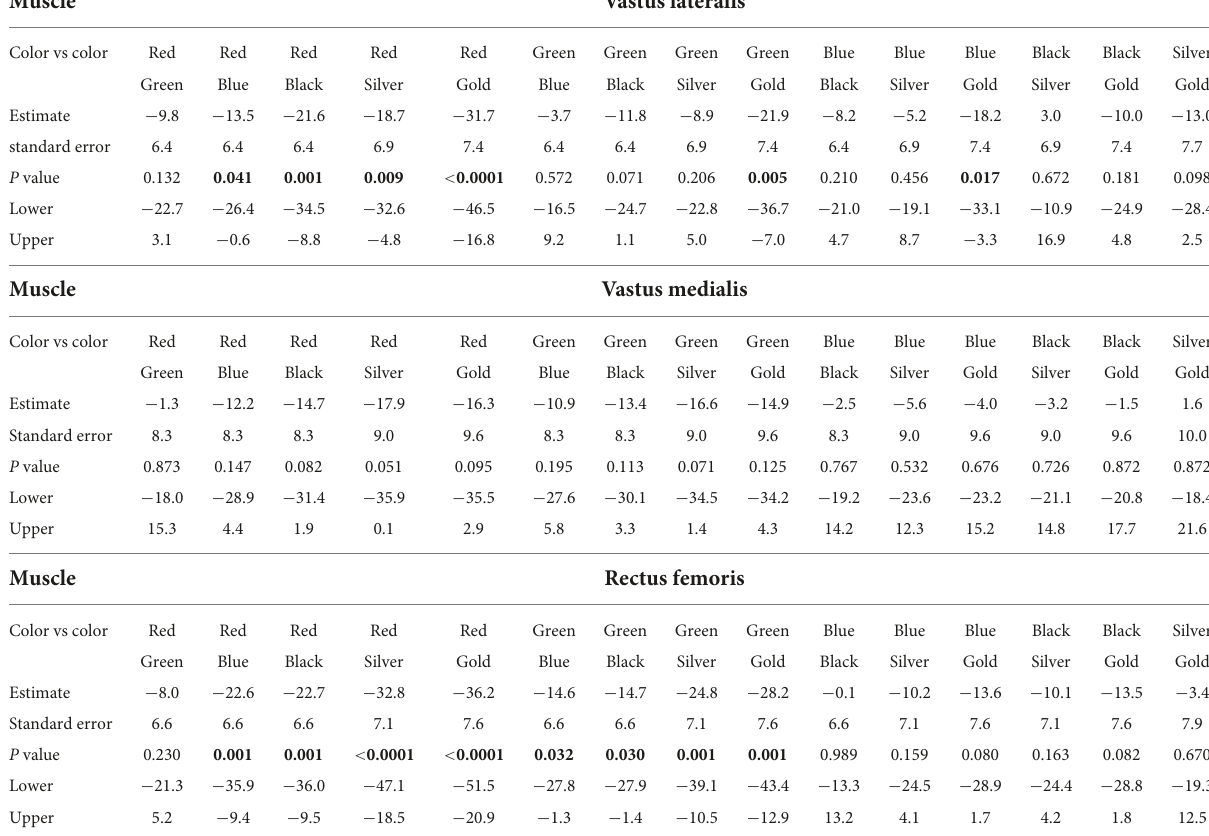
TABLE 4 Differences of least squares means between the different elastic resistances.